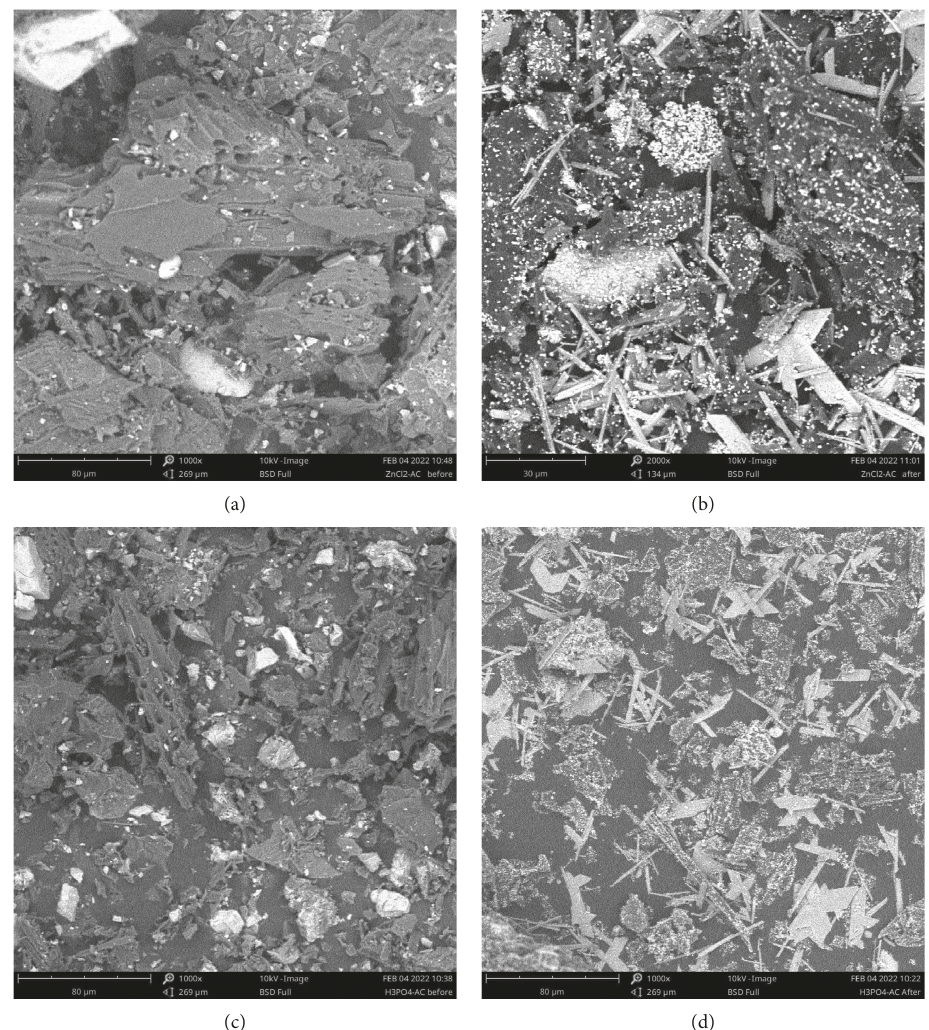
Figure 6: SEM micrographs of the BAC-P and BAC-Zn adsorbent particles showing (a) BSED image at 1000 × of BAC-Zn before adsorption, (b) BSED image at 2000 × of BAC-Zn after adsorption, (c) BSED image at 1000 × of BAC-P before adsorption, and (d) BSED image at 1000 × of BAC-P after